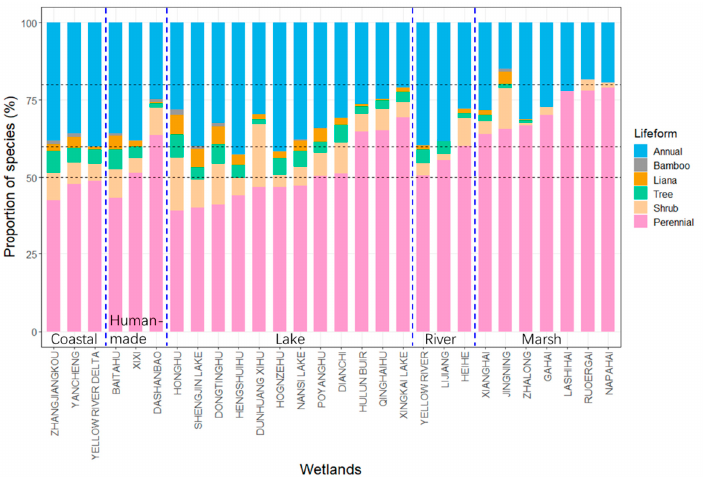
Figure 2. Proportions of wetland plant species of different life forms in the 28 wetlands studied. The species in Asteraceae, Poaceae, and Cyperaceae families were co-dominant in the study wetlands, accounting for 30% of all species (Figure S1). There were 250 dominant species (belonging to 164 genera in 66 families); among them, 40% of the species were in Cyperaceae, Poaceae, and Asteraceae (Figure S2). There were 102 alien invasive species (belonging to 77 genera in 27 families), and half of them were in Asteraceae, Poaceae, and Amaranthaceae (Figure S3). Annual herbs and perennial herbs accounted for 18% and 65% of the dominant species, respectively (Figure S4b). For alien invasive species, annual herbs and perennial herbs accounted for 60% and 31%, respectively (Figure S4c). The species richness of different wetland types was ranked as river < marsh < coastal < human-made < lake (Figure 3a), while PDI was ranked as marsh < river < coastal < lake < human-made (Figure 3b). Thus, human-made wetlands had the highest phylogenetic diversity and marsh wetlands had the lowest phylogenetic diversity. For 23 out of 28 wet- lands, the NTI values were positive, indicating that species were phylogenetically clus- tered in wetland habitats (Figure 3c). PDI was strongly negatively correlated with NTI (Pearson correlation coefficient = − 0.967, p < 0.001). However, species richness was not significantly correlated with PDI (Pearson correlation coefficient = 0.338, p = 0.008), nor NTI (Pearson correlation coefficient = − 0.308, p = 0.111).